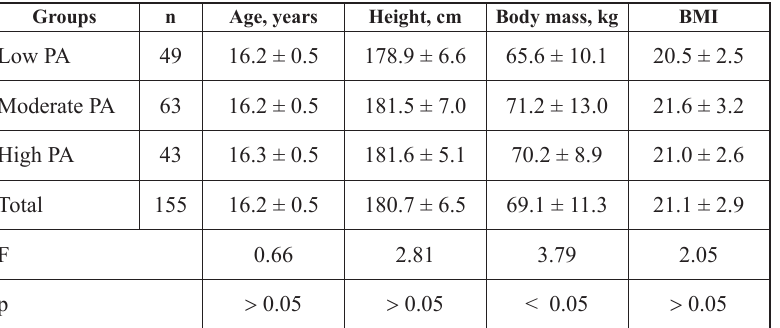
Table 1. Characteristics of the study population (mean ± SD)